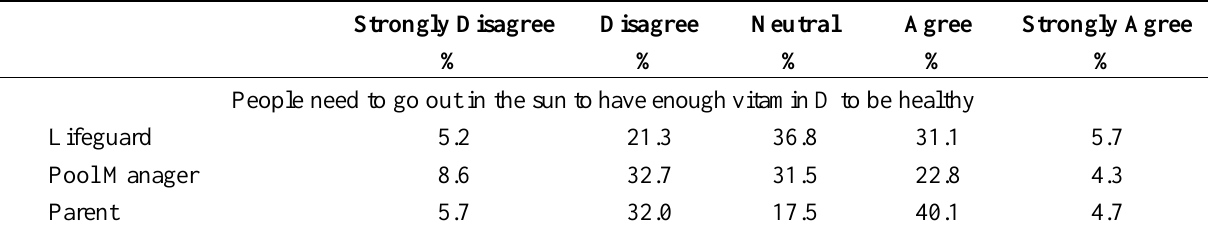
Table 2. Distribution of Responses to the Three Statements about Vitamin